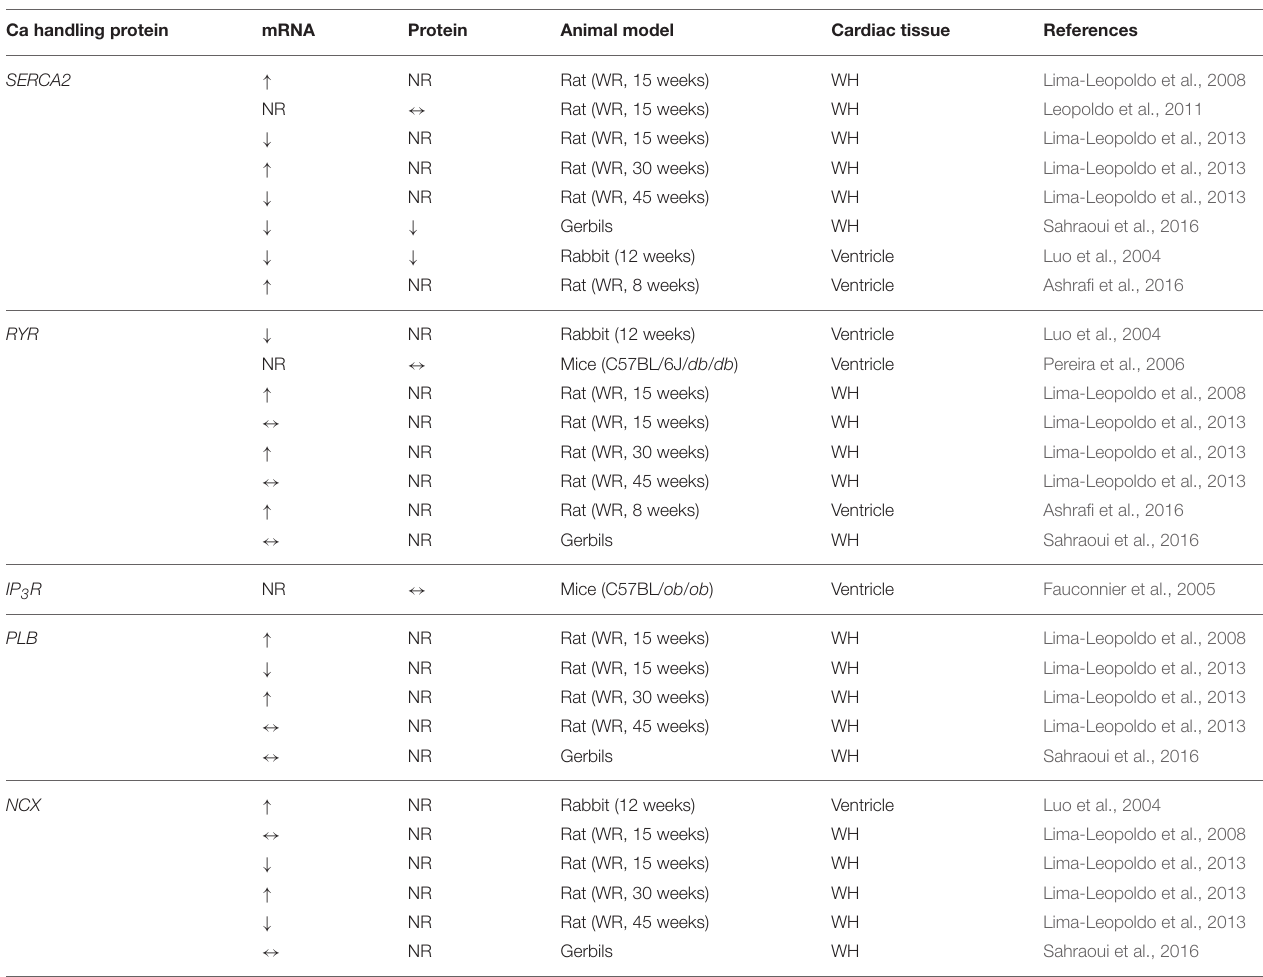
TABLE 2 | Altered functional expression of cardiac Ca handling proteins in obesity. Ca handling